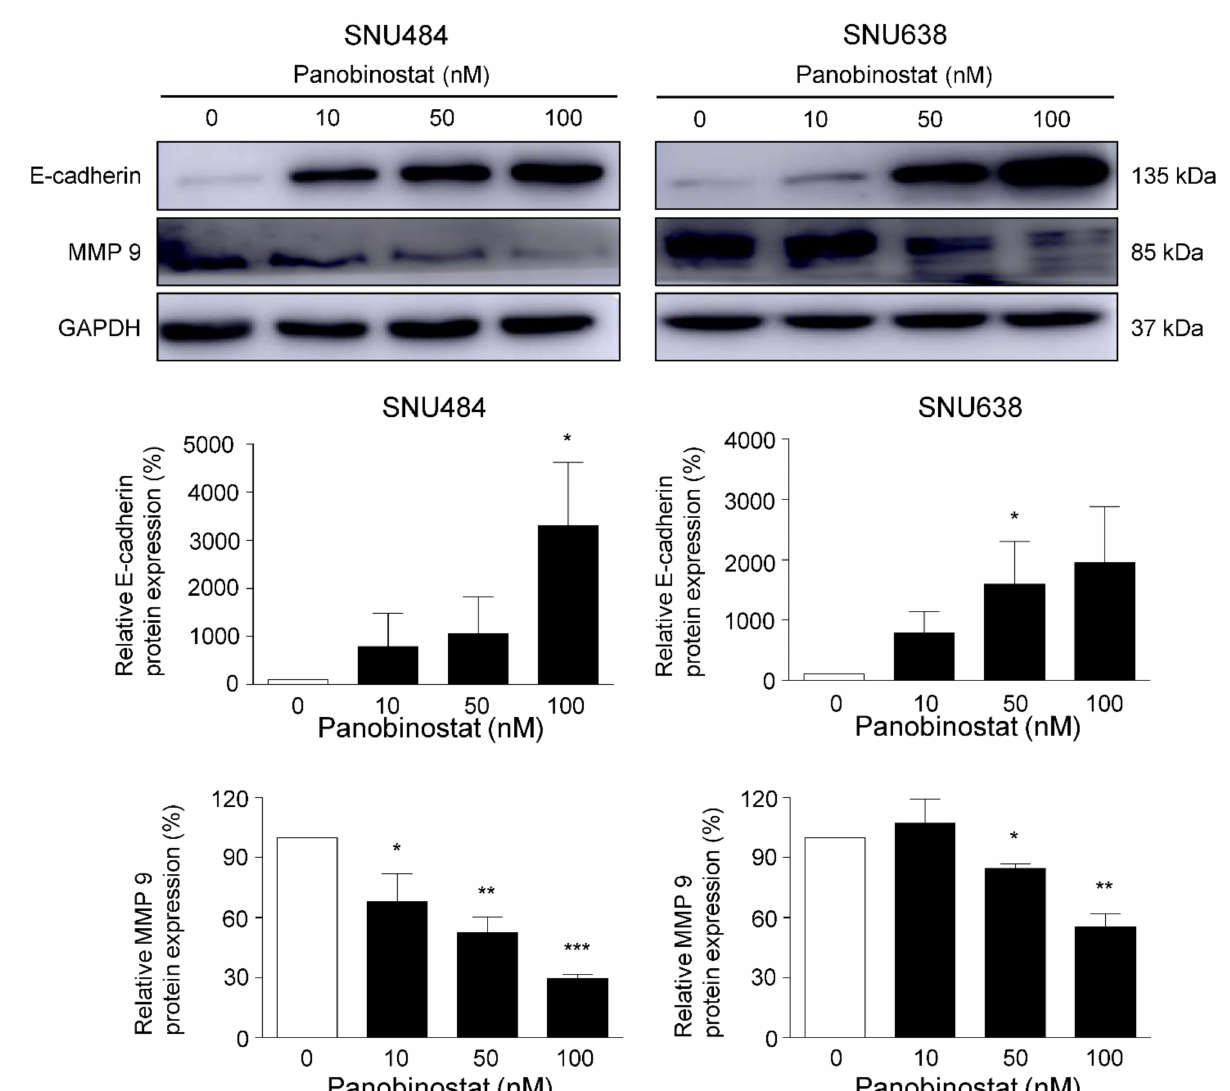
Figure 5. Panobinostat affects metastasis regulatory protein levels in gastric cancer cells. Protein levels of E-cadherin and MMP-9 in SNU484 and SNU638 cells were measured by Western blot after panobinostat treatment (0, 10, 50, and 100 nM) for 48 h. GAPDH was used as an internal control. The Western blot band intensity was quantitatively analyzed using ImageJ software (NIH, Bethesda, MD, USA). Data represent the mean ± SE of three independent experiments. * p < 0.05, ** p < 0.01, and *** p < 0.001 compared with the